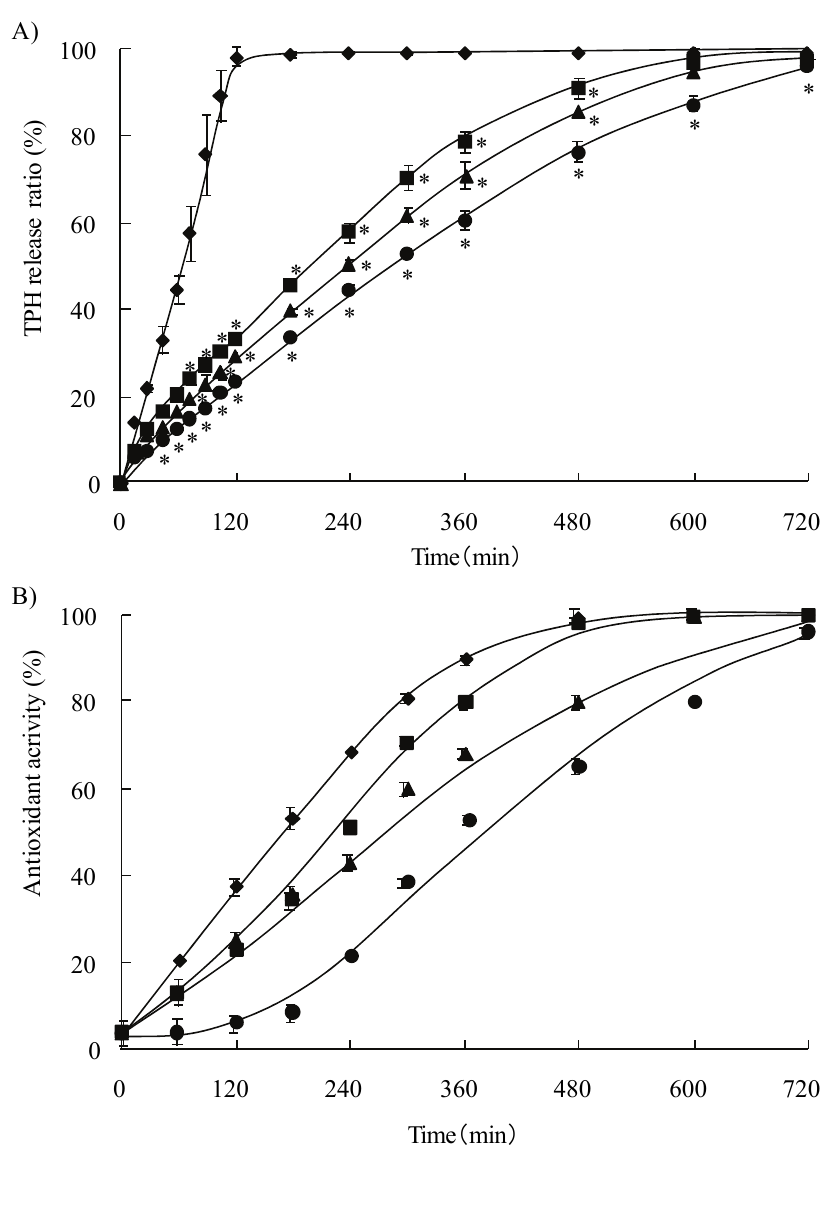
Figure 5. Release profiles of TPH from tablets containing various LMW chitosans in distilled water and antioxidant activity of chitosans TPH tablet. CS1 ( ♦ ), CS2 ( ■ ), CS3 ( ▲ ), and CS4 ( ● ). * P < 0.05 compared to CS1 ( ♦ ).